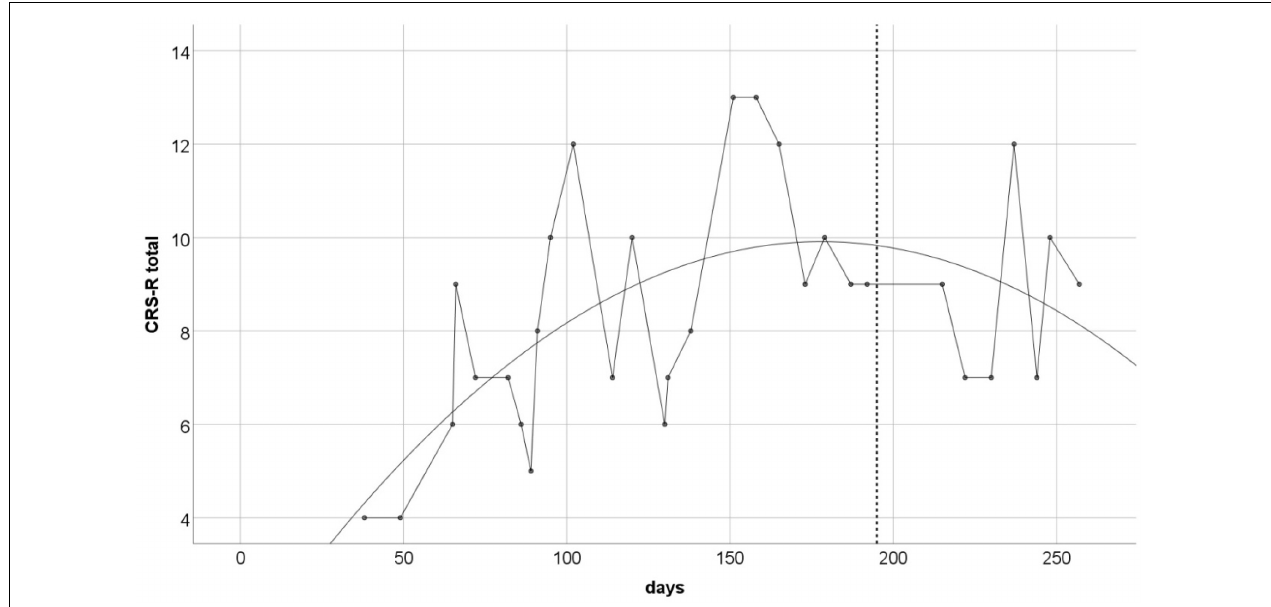
FIGURE 1 | The CRS-R total scores over the study duration. Solid line is the best fitted non-linear regression curve ( r 2 = 0.36, p < 0.01). Vertical dashed line indicates the day of the last taVNS session.